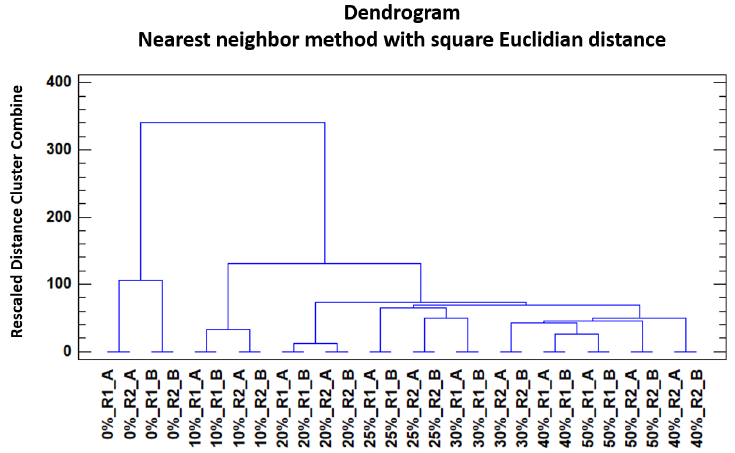
Figure 4. Dendrogram obtained by means of HCA of the unadulterated honey and the adulterated honey samples (D 28X578